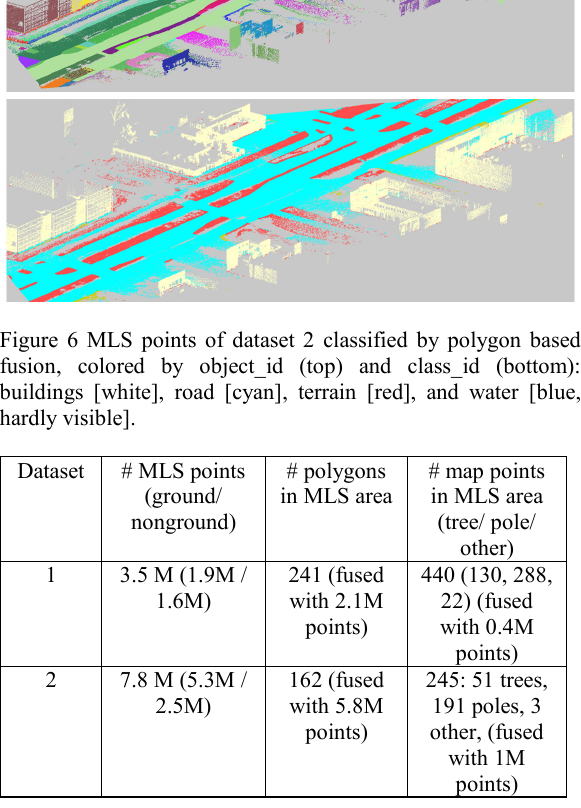
Table 1. Overview on two MLS datasets and their corresponding map polygons and points.